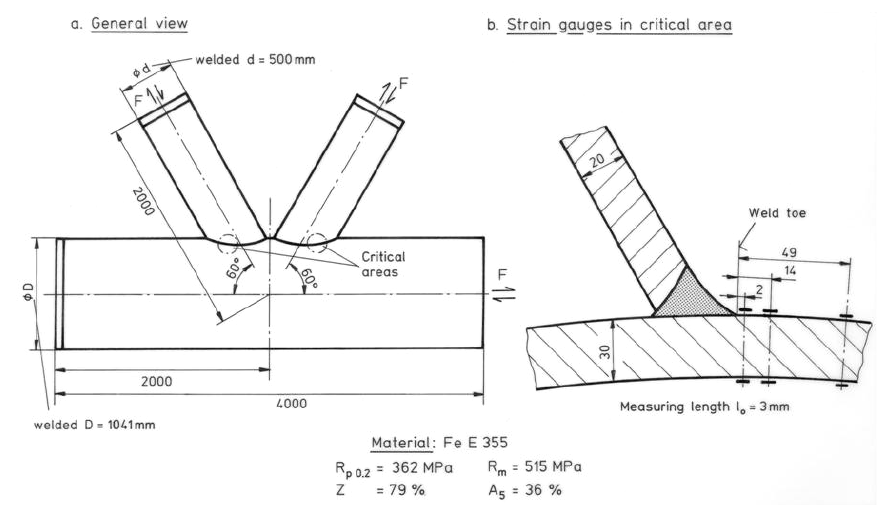
Figure 6: Geometry of welded K-nodes.